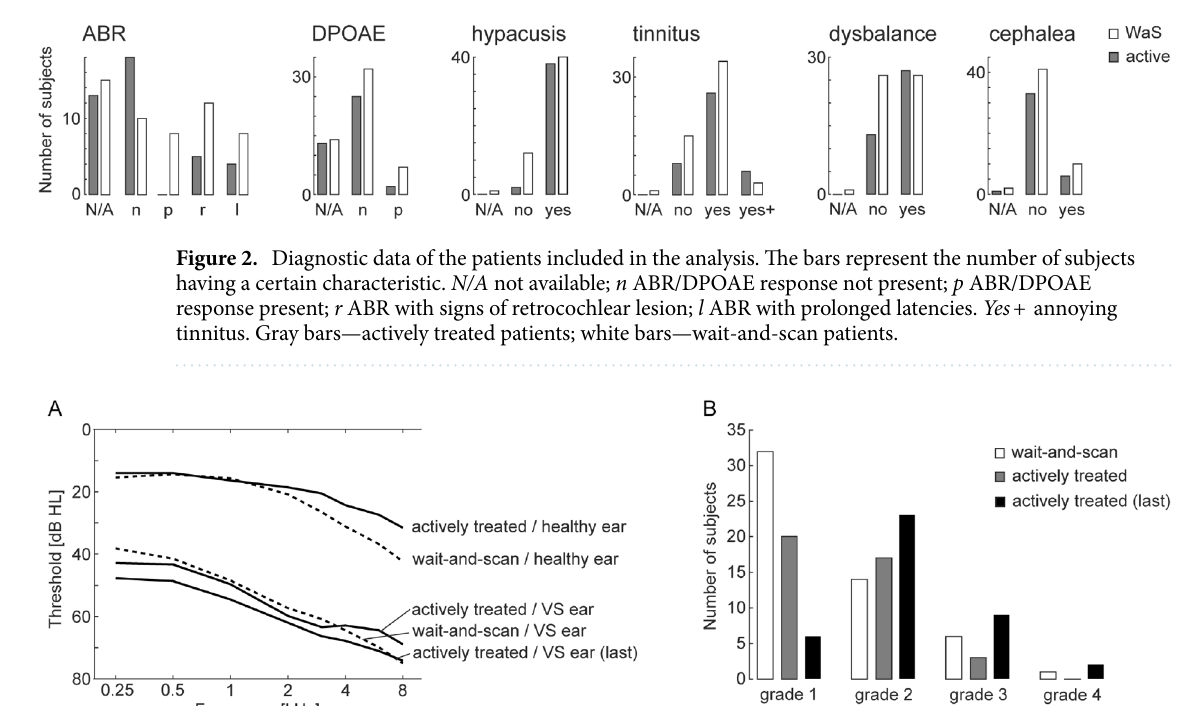
Figure 3. Hearing thresholds and tumor sizes of the patients included in the analysis. (A) Average audiograms recorded in the healthy and diseased ears in wait-and-scan patients and in the patients later changed to active treatment during the initial examination, plus the average audiogram of the diseased ear in the actively treated subjects recorded immediately before the change from wait-and-scan to active treatment. (B) Histogram of Koos grades identified in the actively treated and wait-and-scan patients during the initial examination, and in the actively treated subjects recorded immediately before the change from wait-and-scan to active treatment, the bars represent numbers of subjects having a certain Koos